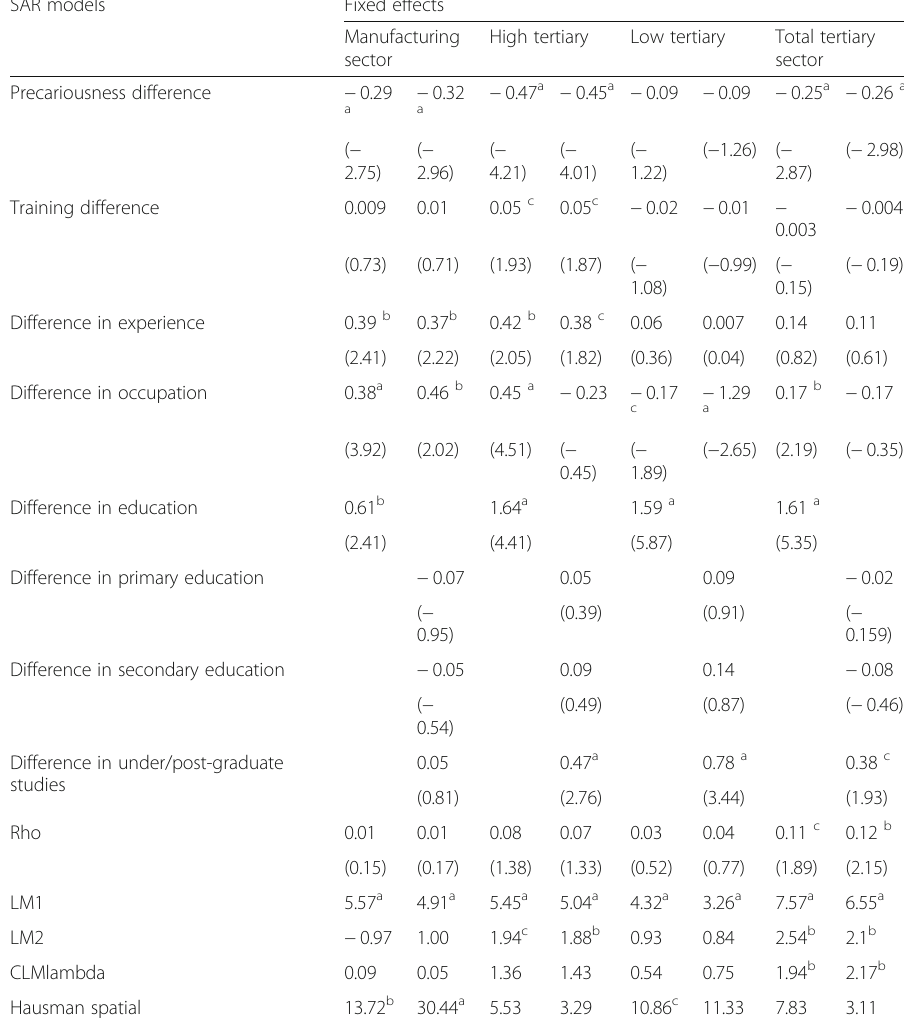
Table 2 Spatial panel data estimation by region. Fixed effects, 2005 – 2018 SAR